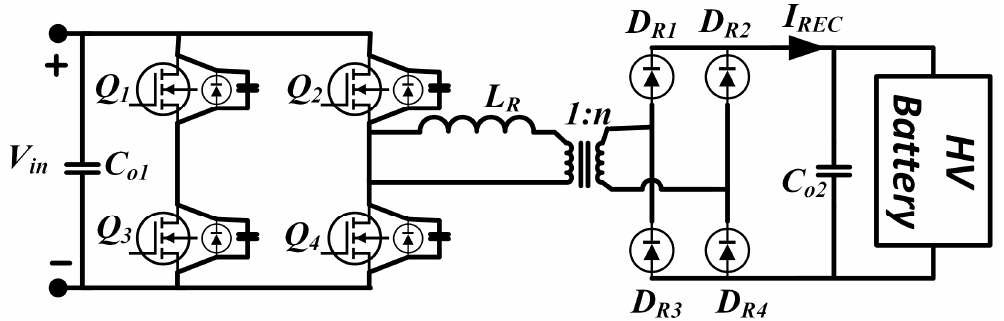
Figure 48. ZVS FB Converter with Capacitive Output Filter [46].